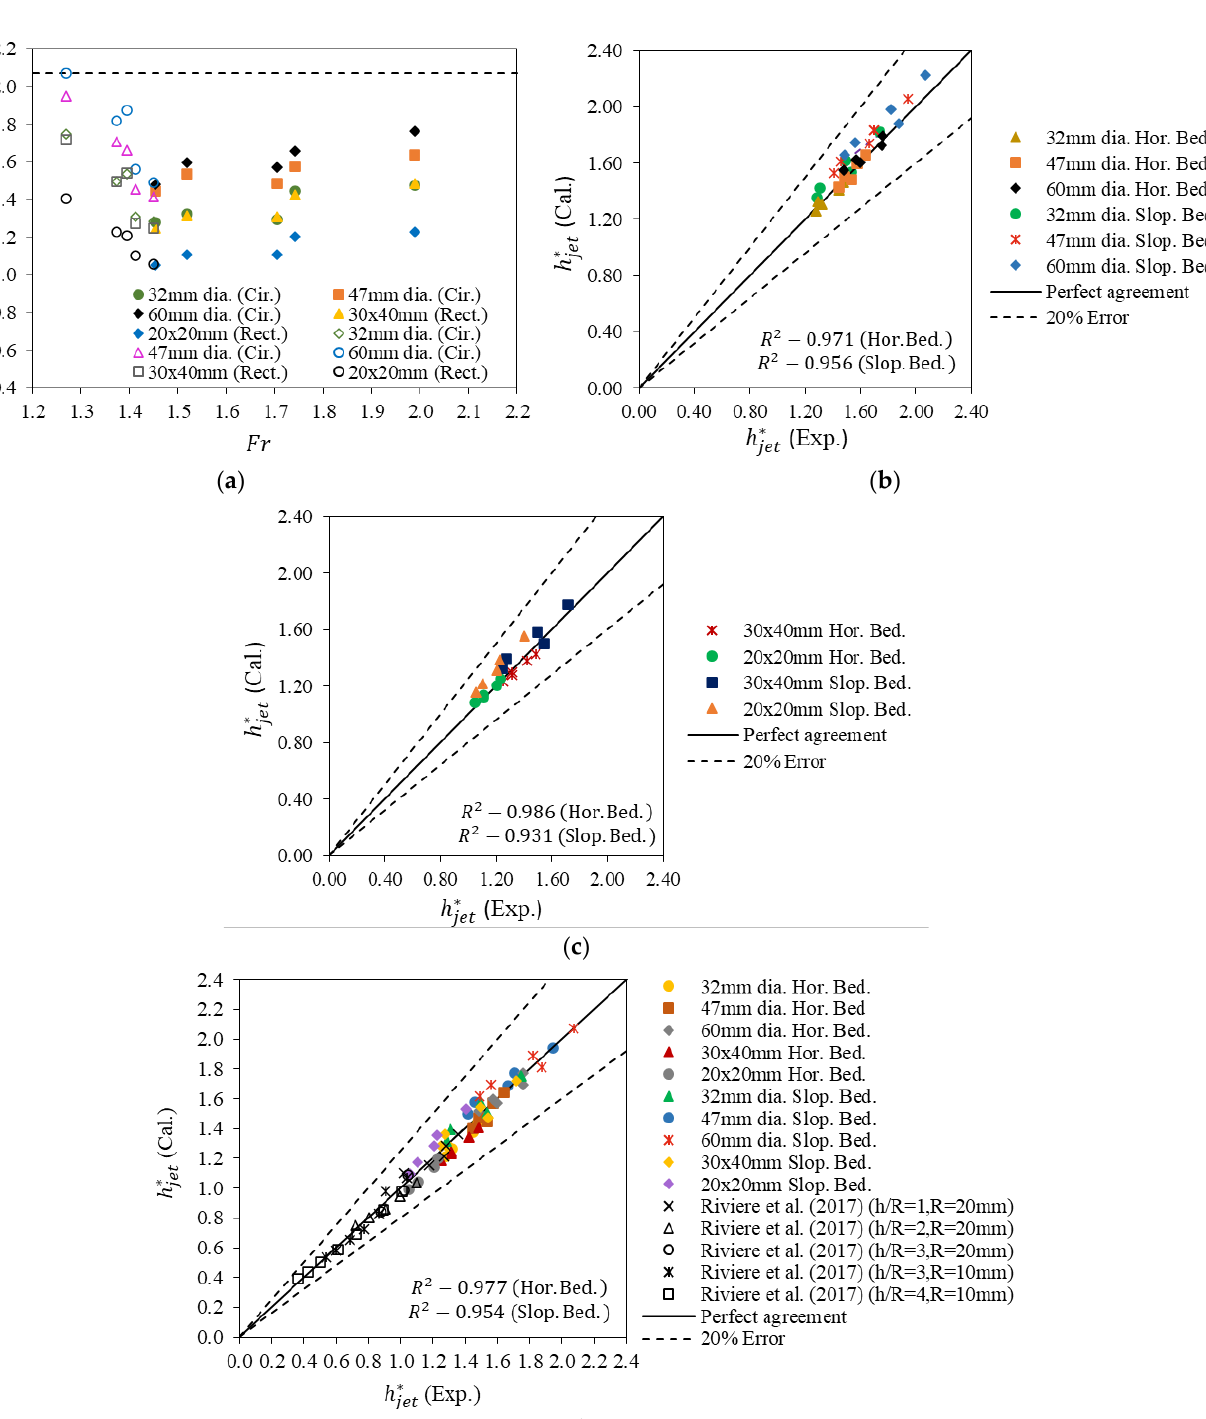
(cid:110)(cid:16) (cid:1)(cid:111) (cid:0) = h U 2 /2 g recorded as a function of jet / jet ) and that predicted according to Equation jet